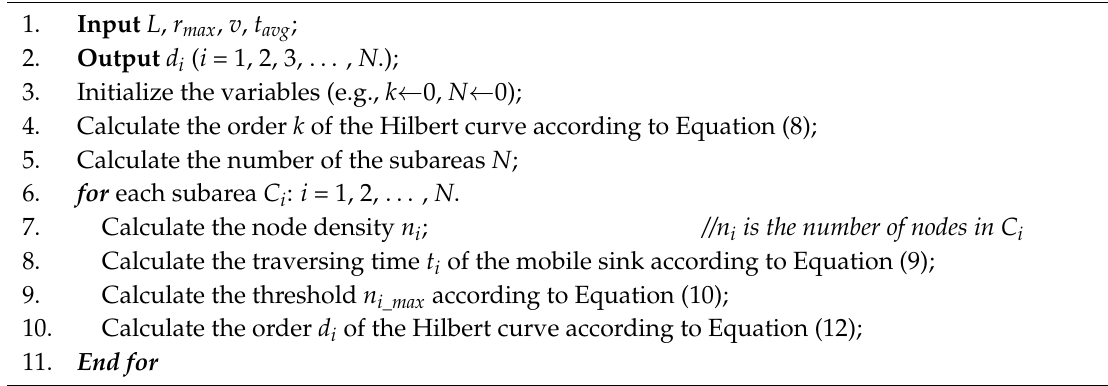
Algorithm 1. The Order of the Hilbert Curve Based on Node Density in a Specific Subarea